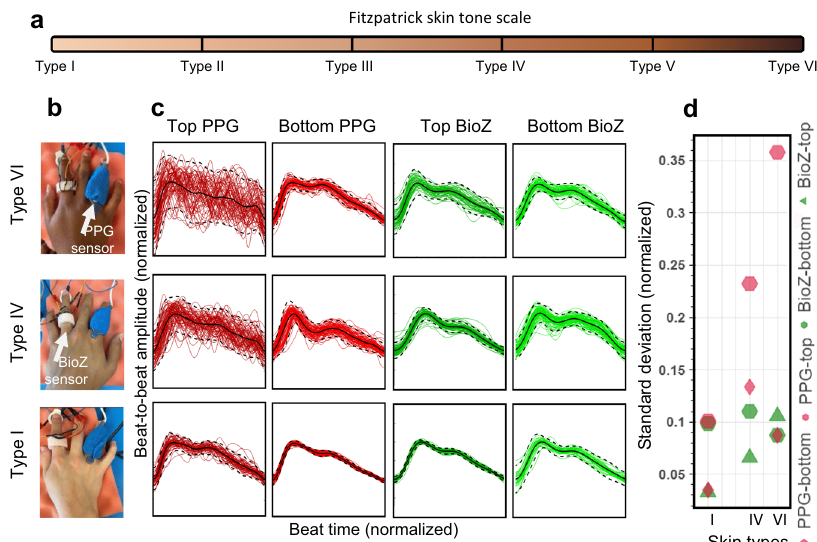
Fig. 6 Comparison of arterial pulse wave captured with bioimpedance and PPG sensors for varying skin tones. a Fitzpatrick skin tone scale. In this study, we used Type I (pale white), Type IV (moderate brown), and Type VI (dark brown) skin types. b Bioimpedance (BioZ) ring sensor and Nellcor Maxfast PPG sensor (660 nm – red) placed at index and ring fi ngers respectively to capture simultaneous blood pressure pulse wave. During the measurements, the PPG sensor is wrapped around the fi nger with a self-adherent cohesive bandage to establish tight fi t contact with the skin. c Normalized waveforms captured in two different scenarios placed on top of the skin, that is darker (plots at fi rst and third columns) when compared to the placement on the bottom with a lighter skin tone (plots at second and fourth columns), from three participants with three skin types I, IV and VI. d Standard deviation values from the normalized beats with respect to the normalized average beat for different sensors and placements for different skin types. The results show a clear degradation in signal consistency for PPG sensor when the skin color gets darker, whereas no signi fi cant correlation was observed for bioimpedance for initial calibrations, as shown in Fig. 3e (Methods). A handheld ultrasound device is used for precise artery localization for optimal placement of the bioimpedance sensor. To achieve a dataset of fl uctuating systolic and diastolic BPs, participants were asked to perform periods of cold pressor exercises, which is the process of increasing BP by placing the individual ’ s non-sensor (right) hand in an ice bath for a time period of 1 – 2 minutes (based off their comfort). The cold pressor